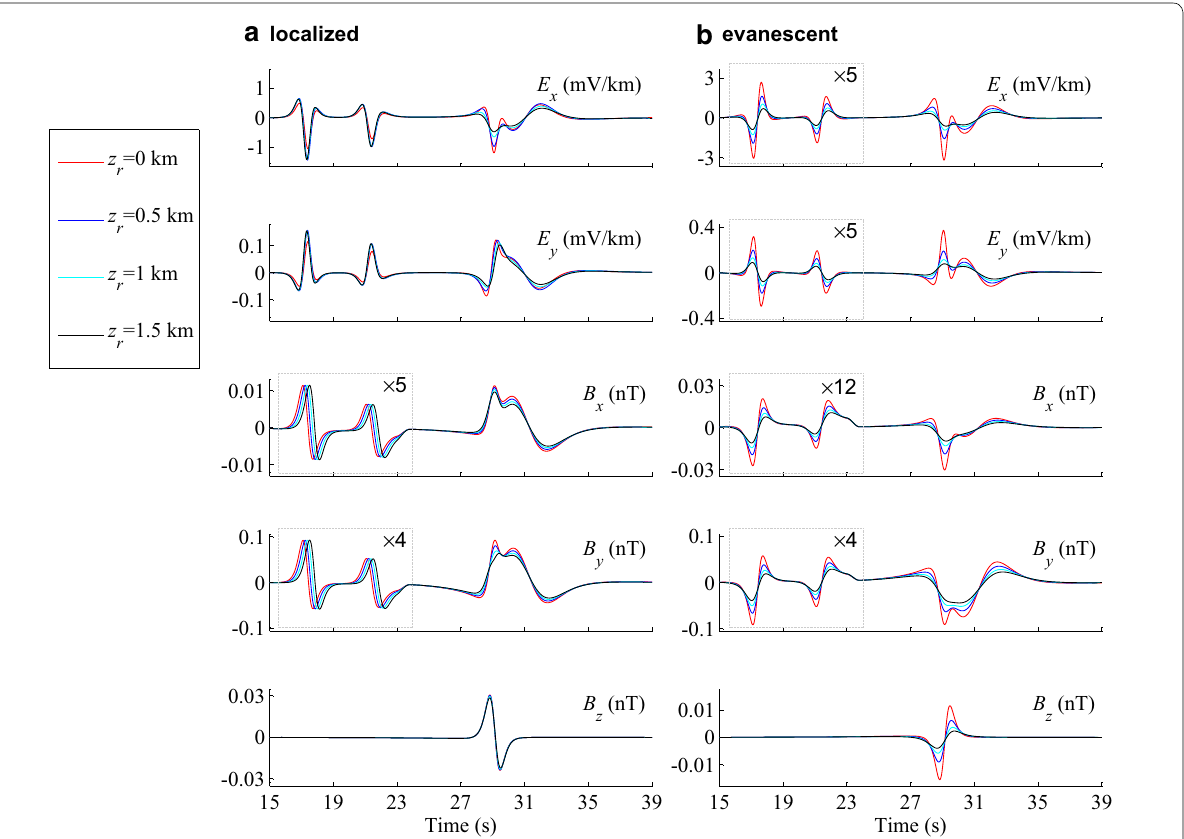
Fig. 6 Comparison between a localized EM fields and b evanescent EM waves. These wave‑fields are calculated for the four receivers with the same lateral offset x r 80,890 m and y r 8680 m, but different depths z r 0, 500, 1000 and 1500 m in the water‑saturated half‑space porous model. The = − = = signals in the gray boxes are amplified to have a better